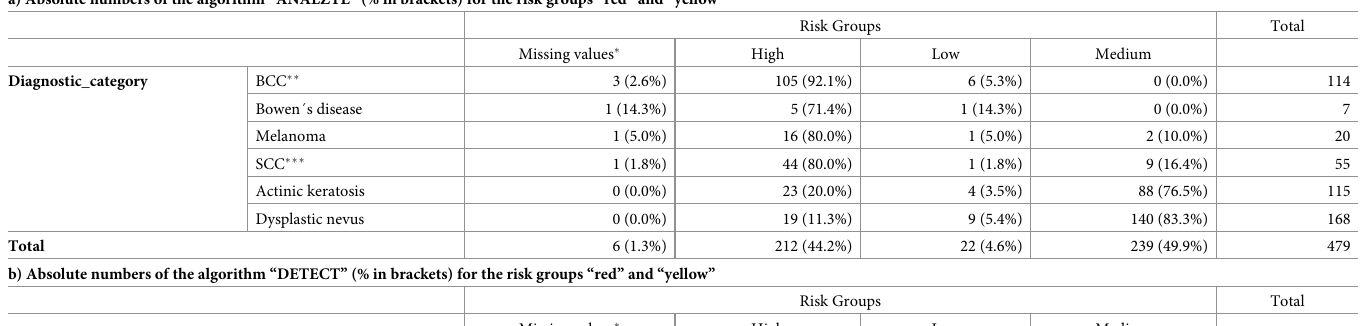
Table 3. Shown are the absolute numbers of the six subcategories “red/high” and “yellow/medium” with their allocation to the three risk groups by each algorithm (a and b). 3c shows the histopathological results of all excised lesions. 3d and 3e display crosstabulations of the respective algorithm with the clinical category.